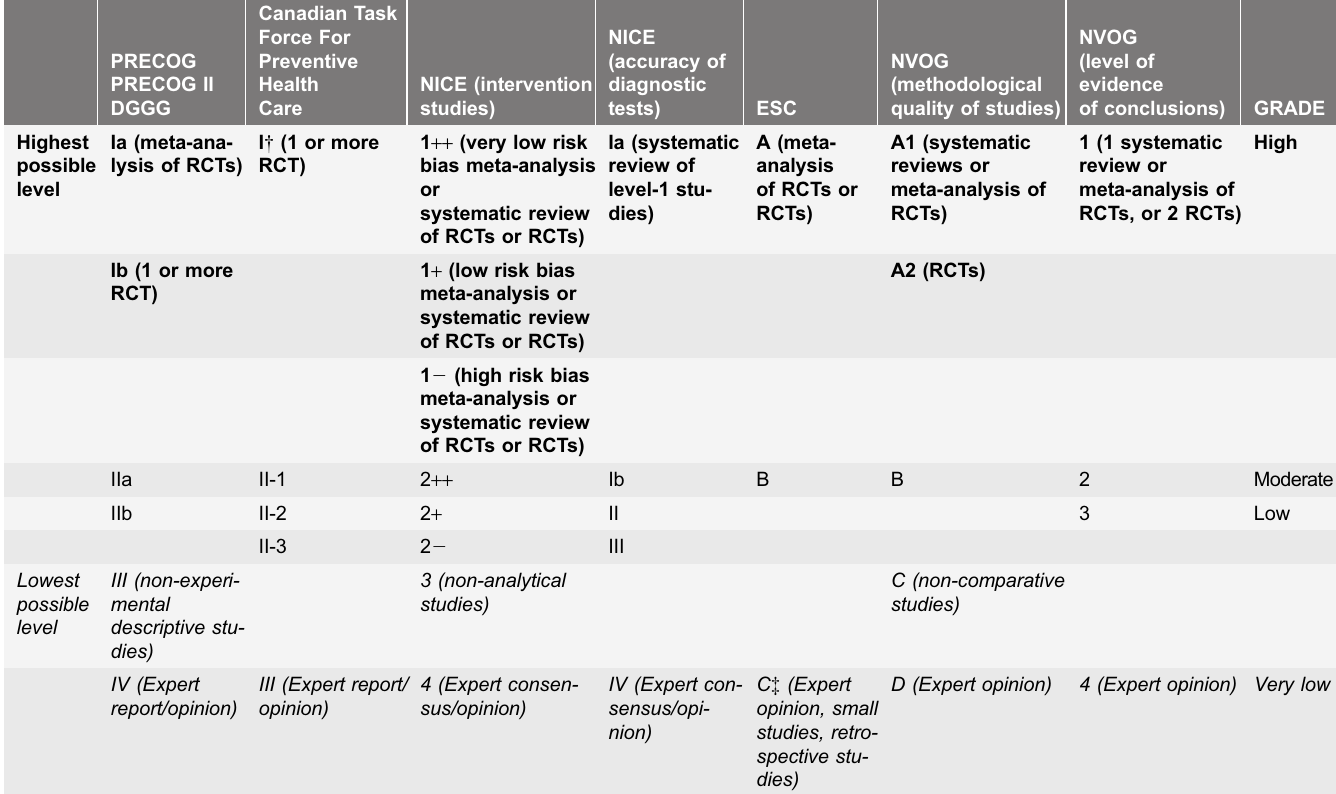
*Bold indicates comparable gradings for ‘high quality’ evidence. Italic indicates comparable shading for ‘low quality’ evidence. { Does NOT include meta-analysis of RCTs. { includes small studies and retrospective studies as